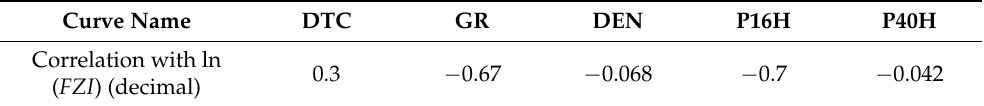
Table 3. Correlation analysis between single curve and ln ( FZI ).